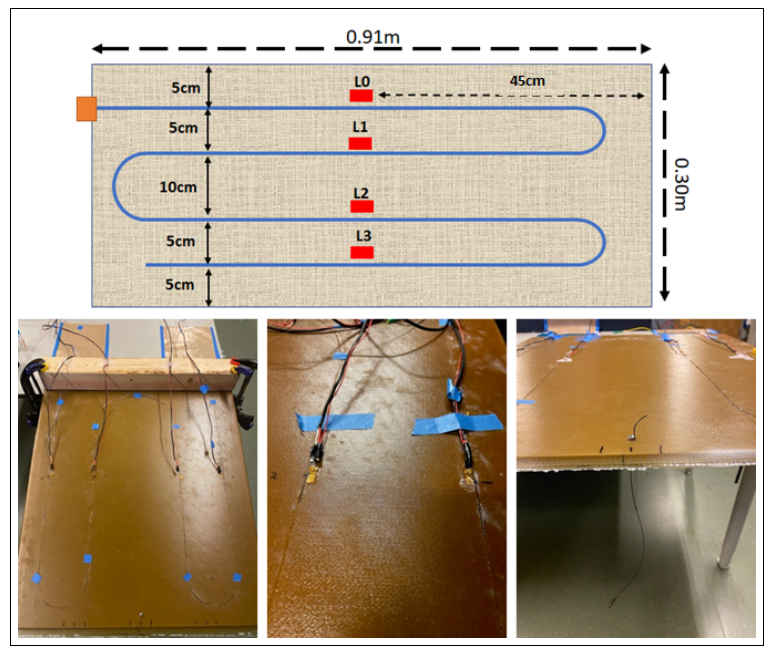
Figure 2. Canteliever test set up and textile